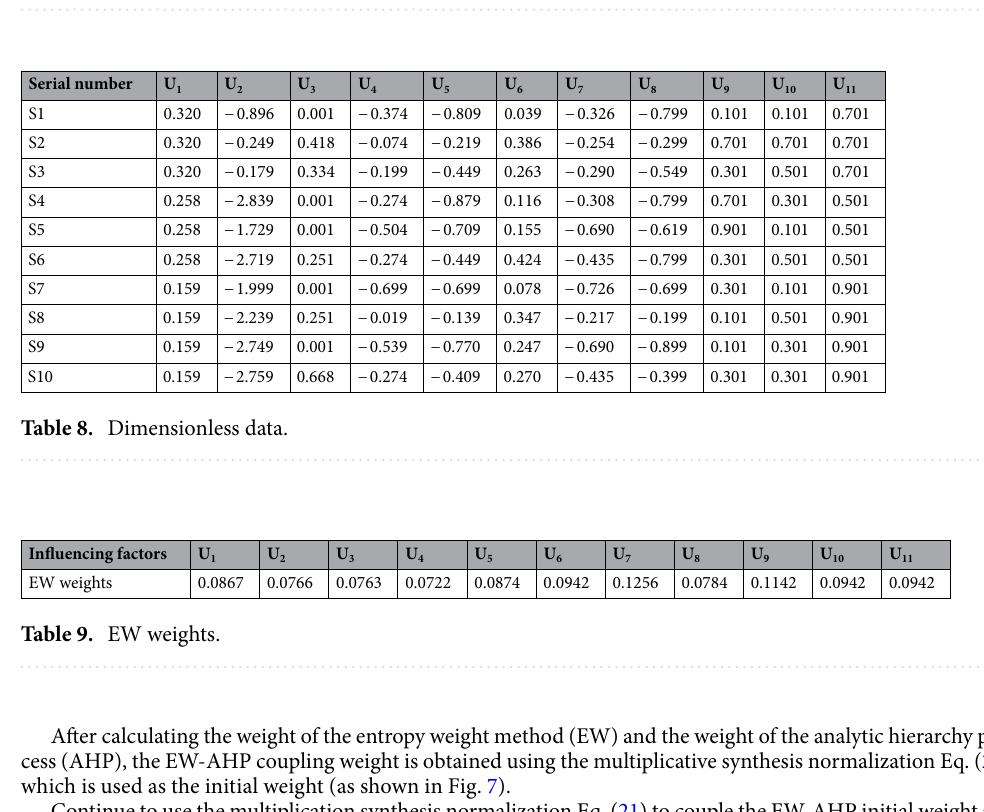
Table 7. TQ-III weights.